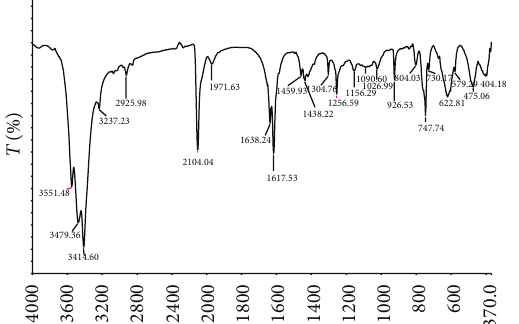
Figure 3: 13 C NMR spectrum of L 1 in CDCl 3 .